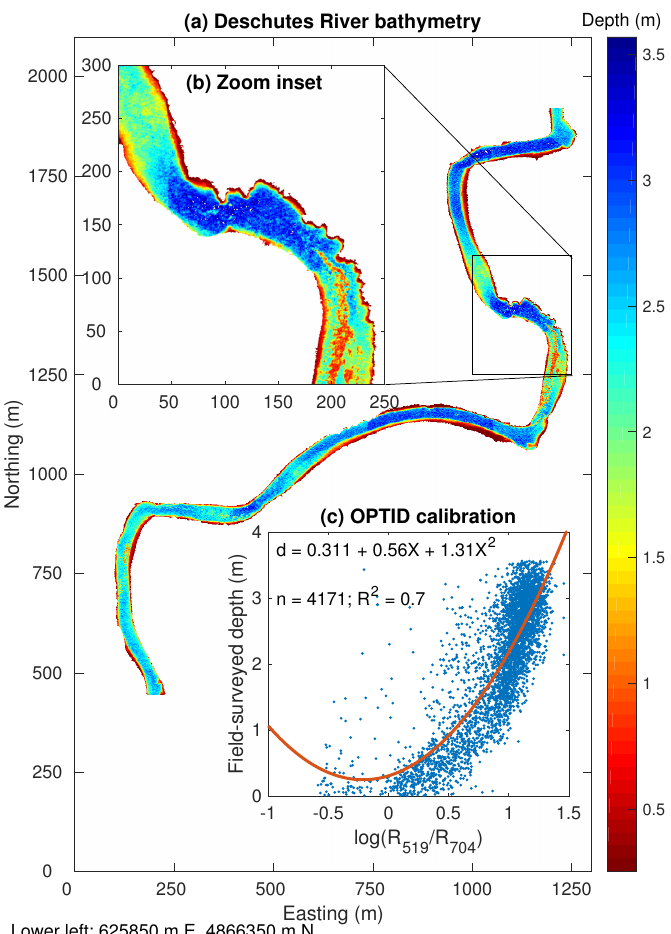
Figure 9. ( a ) bathymetric map derived from a hyperspectral image of the Deschutes River based on the Optimal Band Ratio Analysis (OBRA) relation for the depth increment inferred to correspond to the sensor’s maximum detectable depth d max ; ( b ) zooms in on the portion of the channel indicated by the rectangle in ( a ). Pixels inferred to have depths in excess of d max have been masked and appear as blank (white) areas in these maps; ( c ) calibration scatter plot relating the image-derived quantity X to depth d